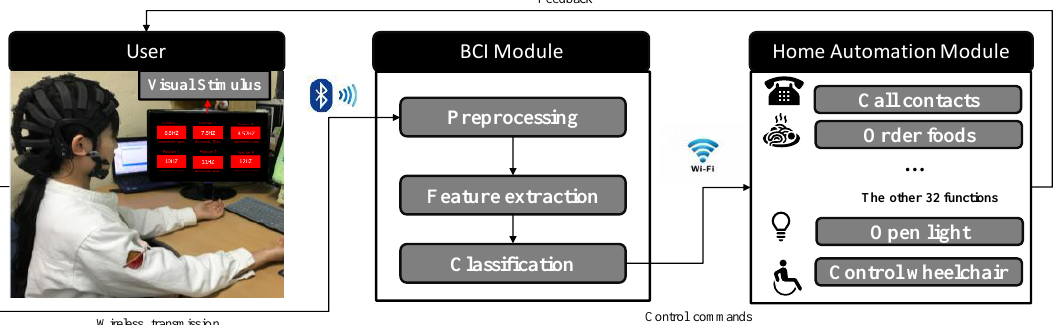
Figure 1. The control structure for our hybrid BCI system.